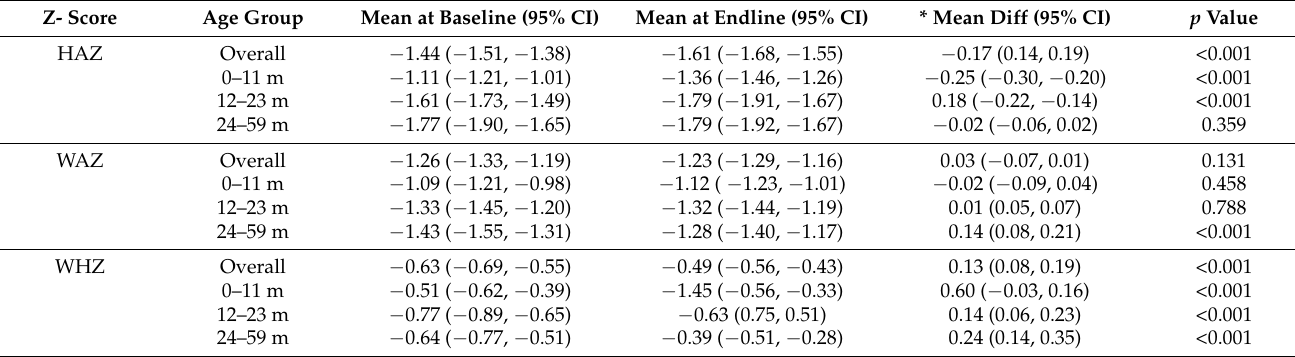
Table 2. Difference between baseline and endline height-for-age z-score, weight-for age z-score, and weight-for-height z-score among the children under the age of 5 ( n = 1512) of Global Enteric Multicenter Study (GEMS), by age group.